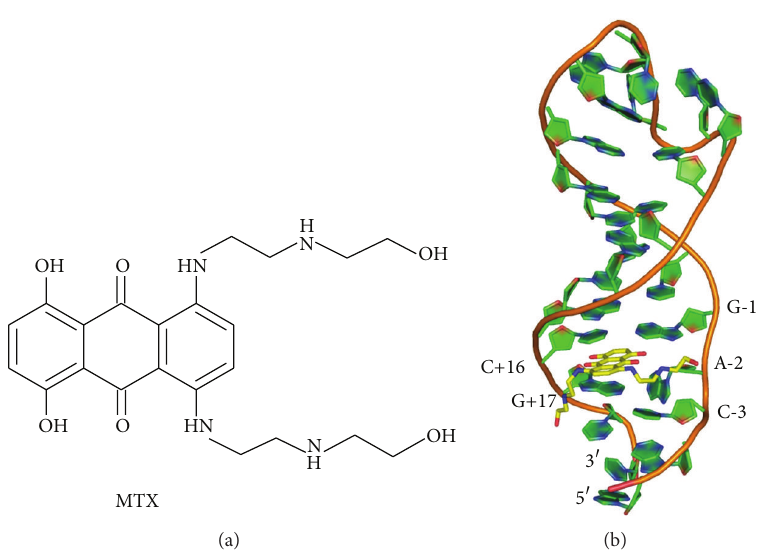
Figure 2: (a) Mitoxantrone structure (MTX). (b) NMR solution structure of MTX (yellow) bound to the tau RNA stem-loop. The aromatic region is intercalated between two G-C base pairs and flanking an unpaired adenosine. Side chains lie along the major